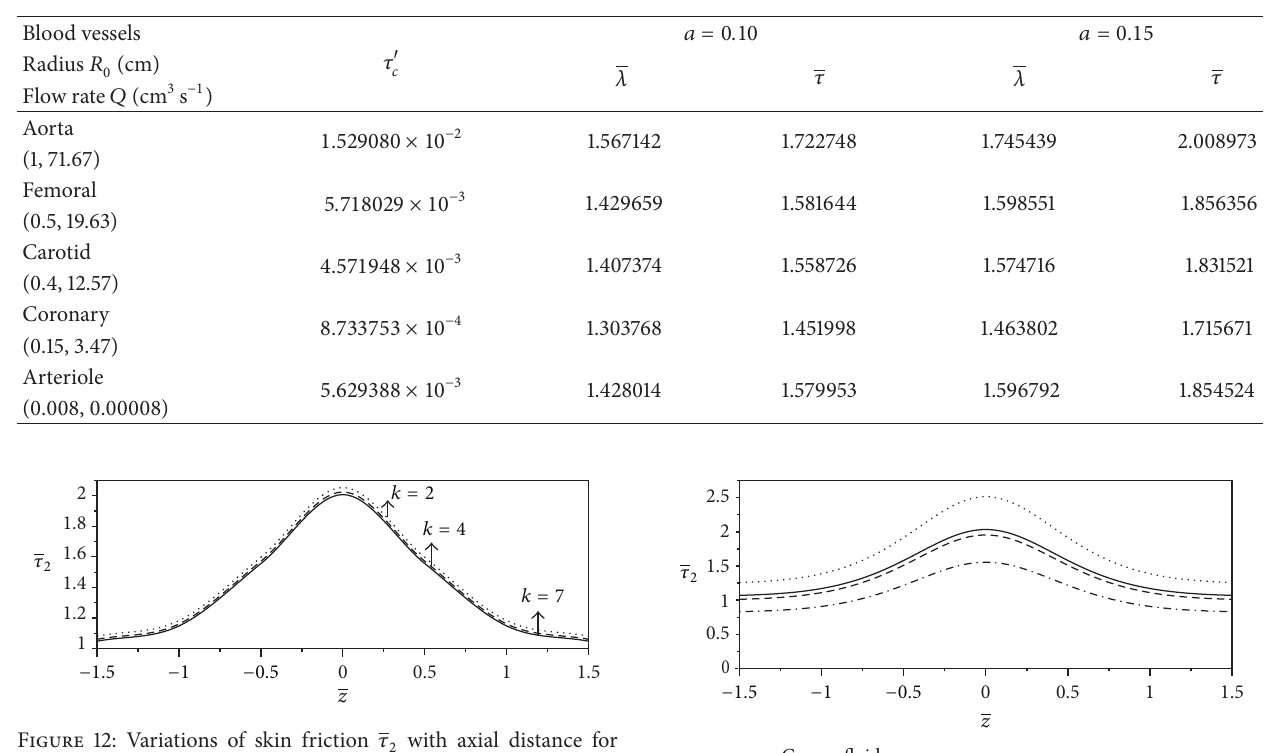
Figure 12: Variations of skin friction 𝜏 2 with axial distance for different values of viscosity 𝑘 .